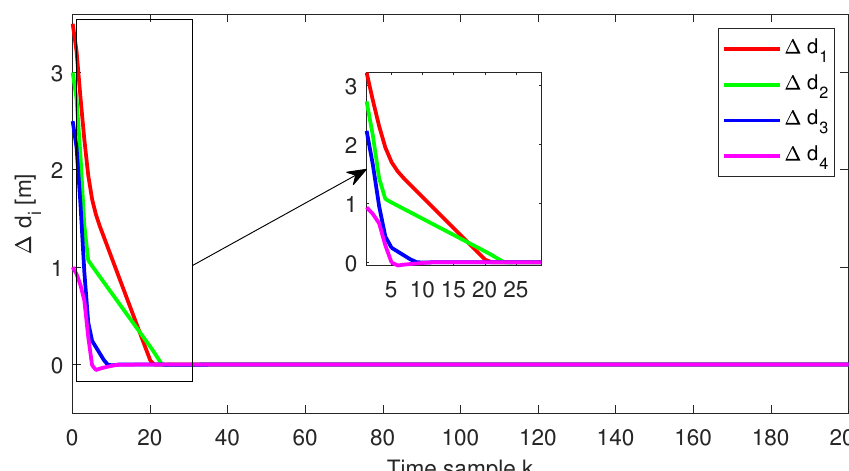
Figure 6. Test 4 —Acceleration for each platoon vehicle.